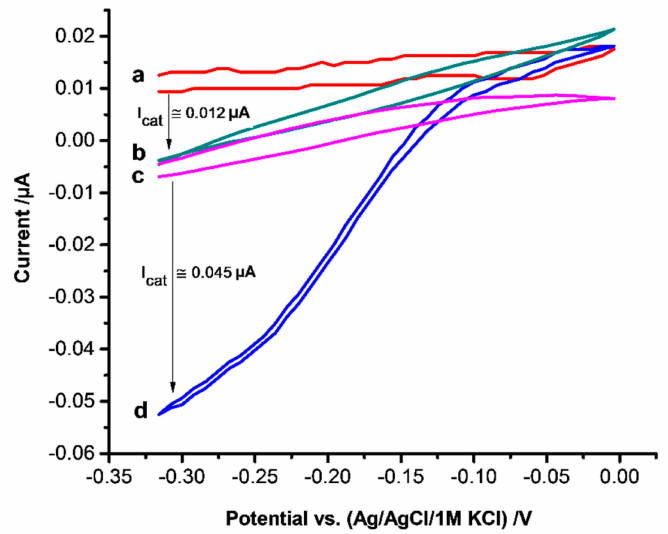
Figure 5. CVs of NIP (a, b) and HTHP loaded MIP (c, d) in absence (a, c) and in presence of 100 µ M H 2 O 2 (b, d) in 2.5 mM Tris buffer at pH 8, scan rate of 5 mV/s. MIP and NIP were incubated in 52 µ M HTHP solution for 1 h before